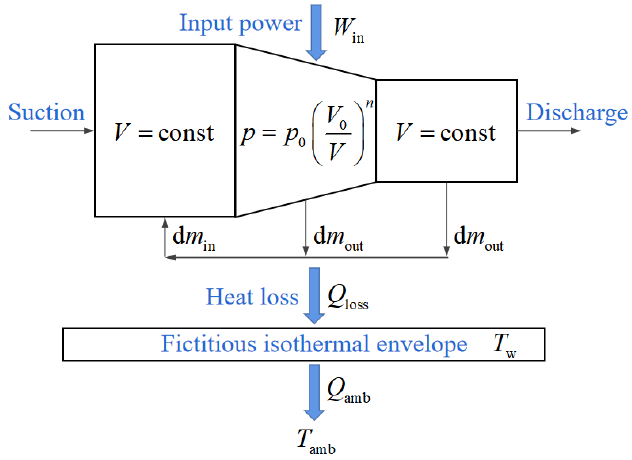
Figure 3. Schematic diagram of a semi-empirical model of screw machines.